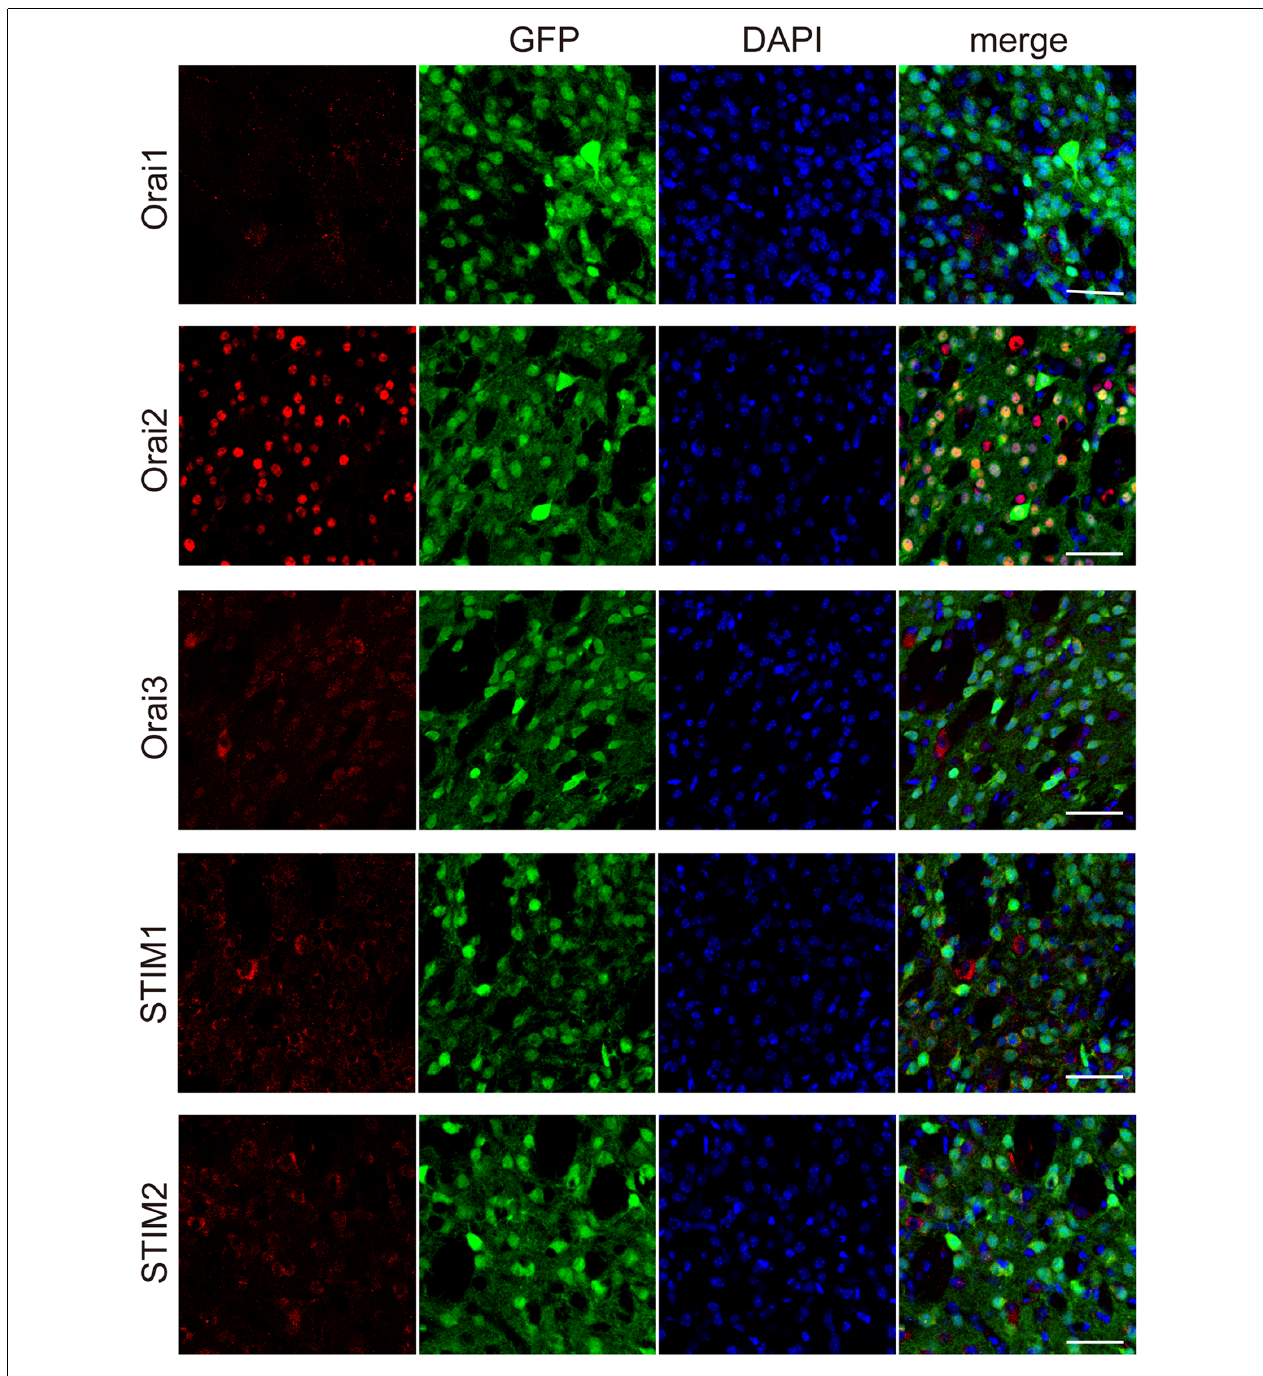
FIGURE 4 | Each of the molecular components of SOCE expressed at different levels in the striatal GFP-positive cells. Confocal microscopy images of the sections through the dorsal striatum obtained from GAD67-GFP mice, which were stained for Orai1, Orai 2, Orai3, STIM1, or STIM2 (red), along with GFP (green). Blue staining represents DAPI. Scale bar: 50 µ